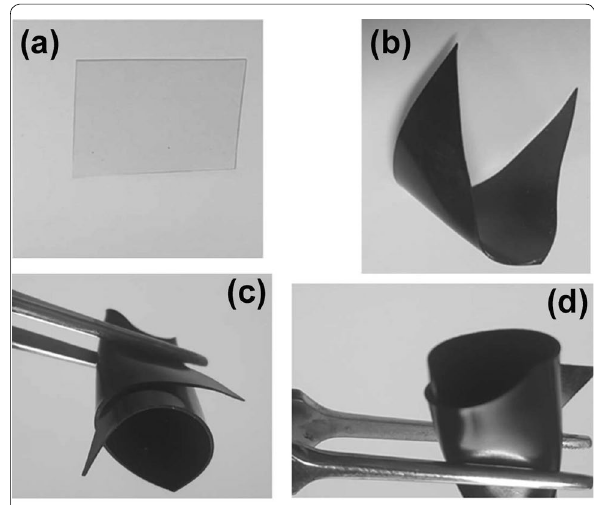
Fig. 2 The photography images of neat EPR ( a ) and GNS/EPR 1–5 ( b – d